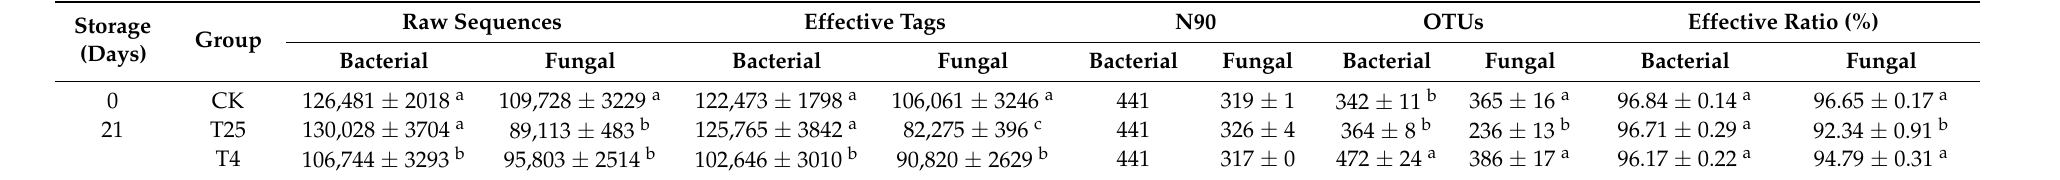
Table 1. Raw sequencing data of bacteria and fungi on the surface of the blueberry samples.